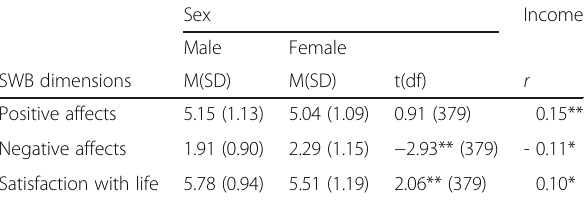
Table 3 Comparison of affects and satisfaction with life between the sexes, and correlation between